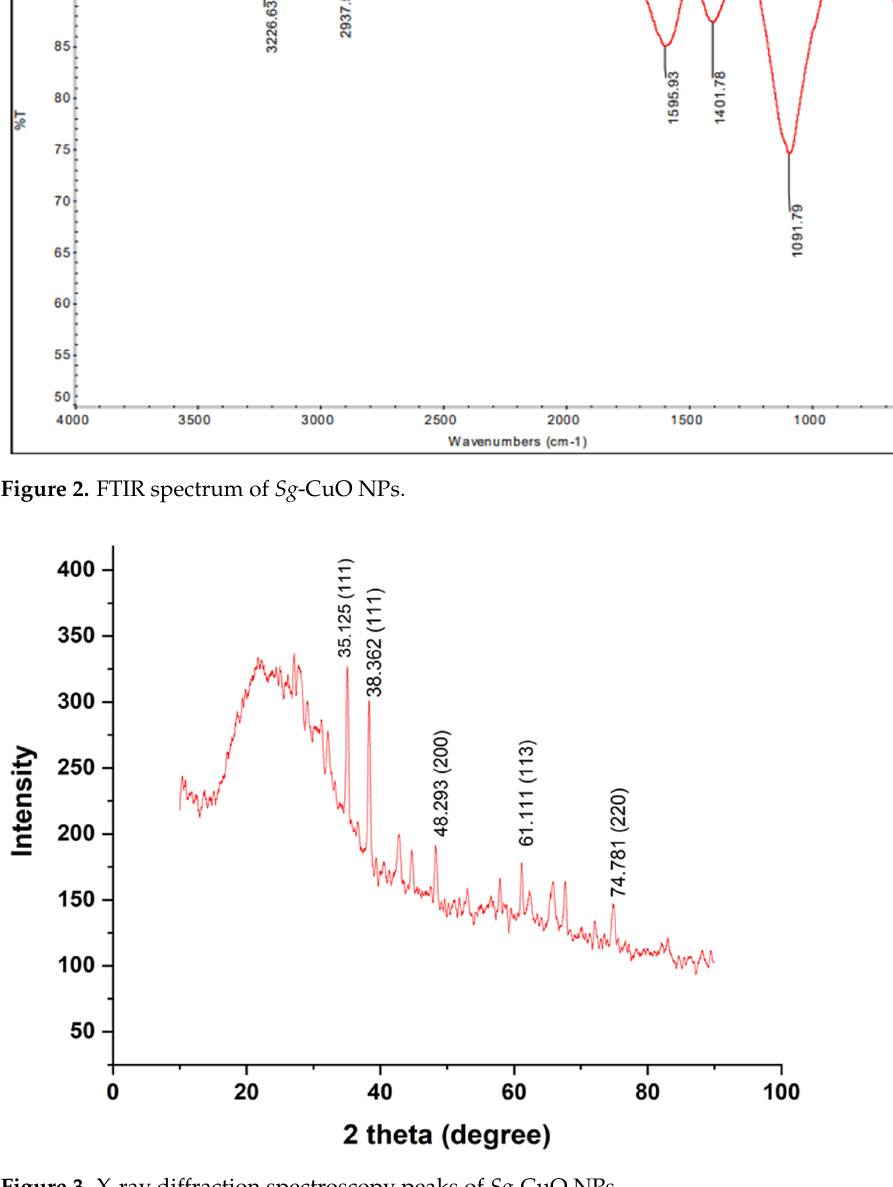
Figure 2. FTIR spectrum of Sg -CuO NPs.